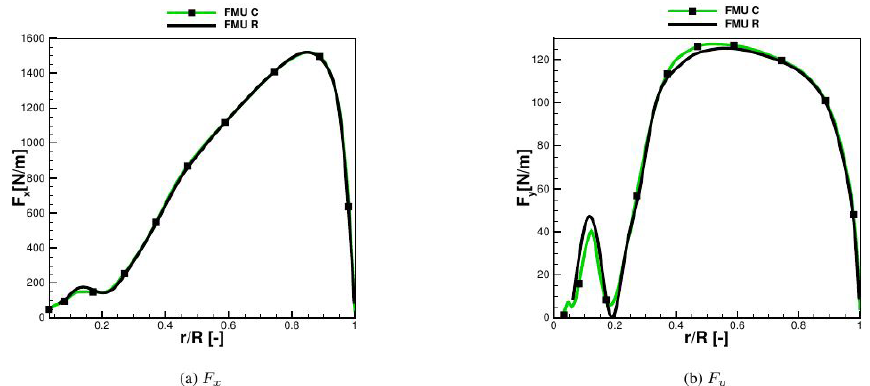
Figure 11. Sectional loads for FMU: comparison between rigid (R) and coupled (C) calculated with CFD at 6.1ms − 1 .